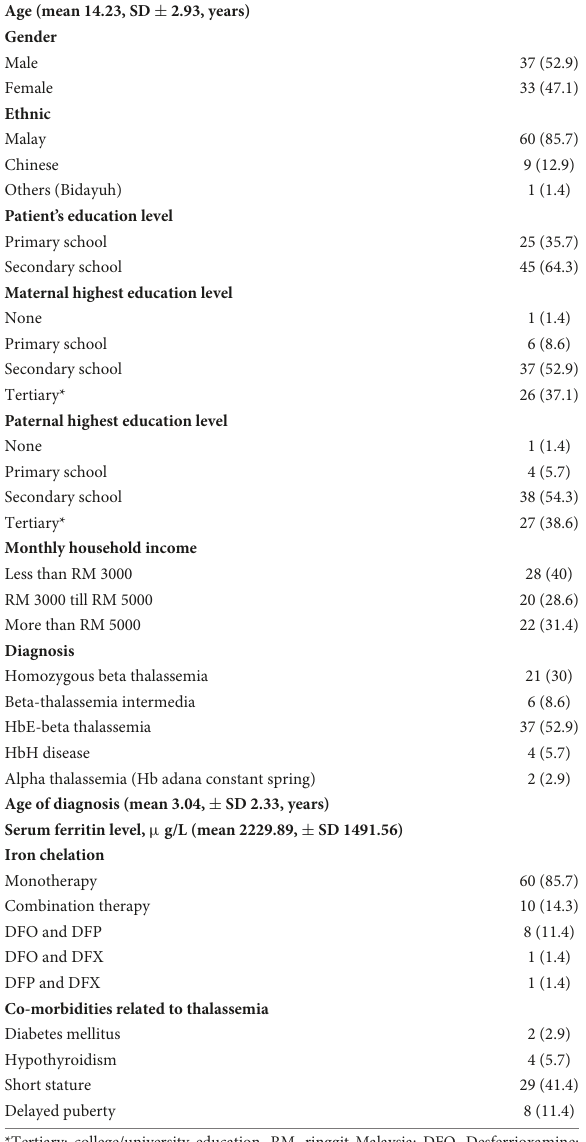
TABLE 1 Socio-demographic and clinical characteristics of 70 thalassemia patients.